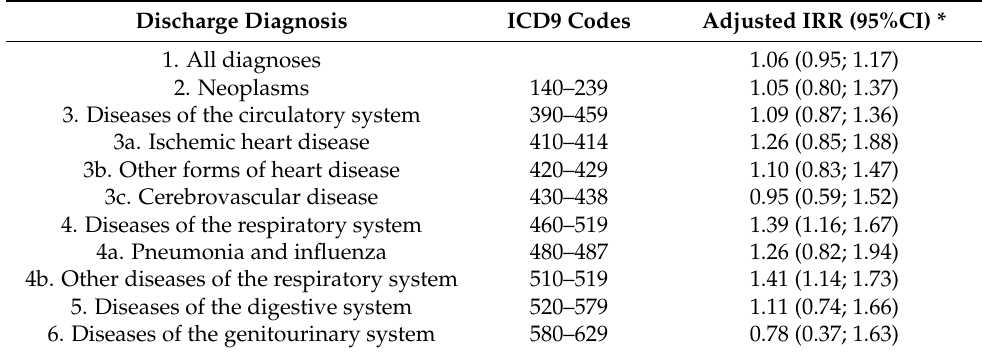
Table 3. Incidence rate ratios (IRRs) with 95% CIs for the association between admission during nighttime–weekends–holidays (vs. daytime-weekdays) and mortality by discharge diagnosis.